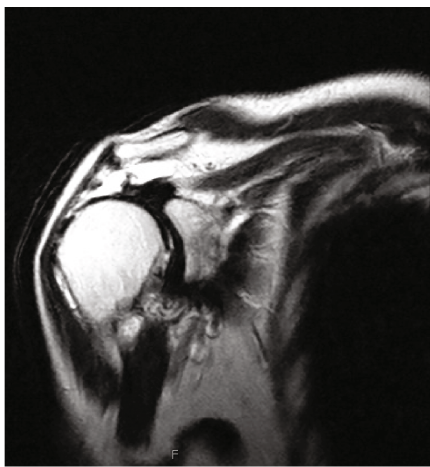
Figure 1: Coronal view of a T2-weighted MRI of the right shoulder following consultation for a rotator cu ff tear.